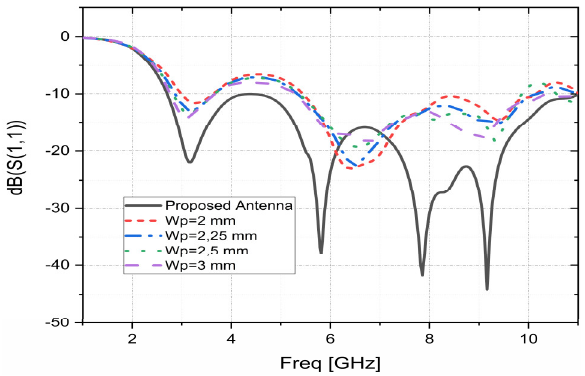
Figure 4. Simulated S11 parameters as functions of Wp.